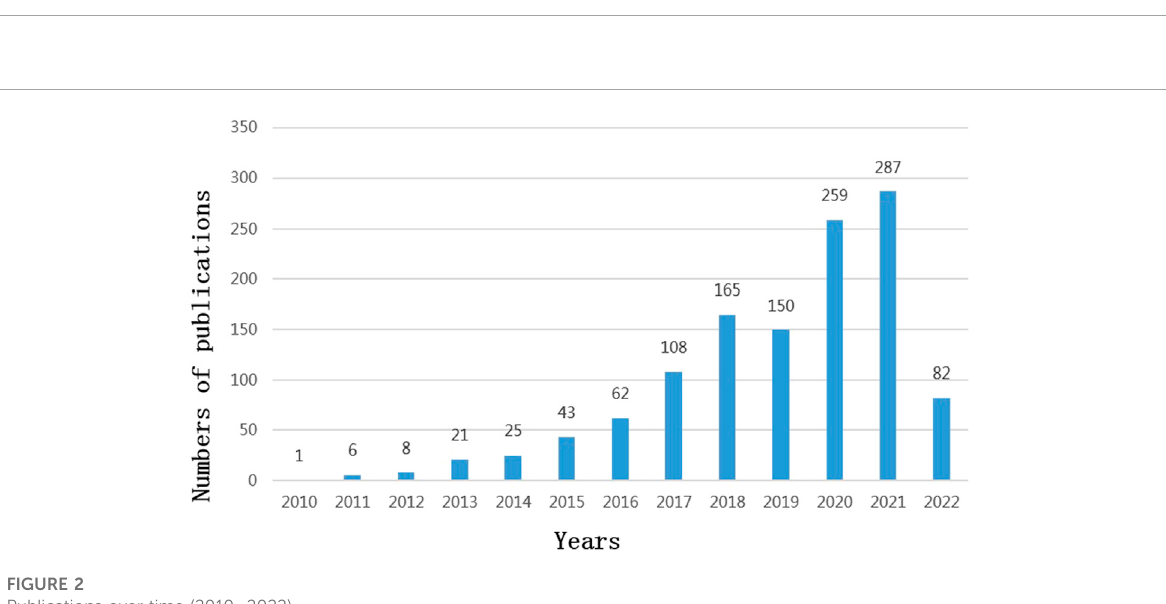
FIGURE 1 Schematic diagram of literature screening. Data collection was done on a single day, 12 May 2022. A total of 1,243 records from the Web of Science Core Collection (WoSCC) database was retrieved. Then, 26 data were excluded, including meeting abstracts, book chapters, proceedings papers, editorial material, corrections, and retracted publications. Finally, 1,217 pieces of data were obtained. Data were imported into theCiteSpace software (version 5.8. R3) for further analysis.